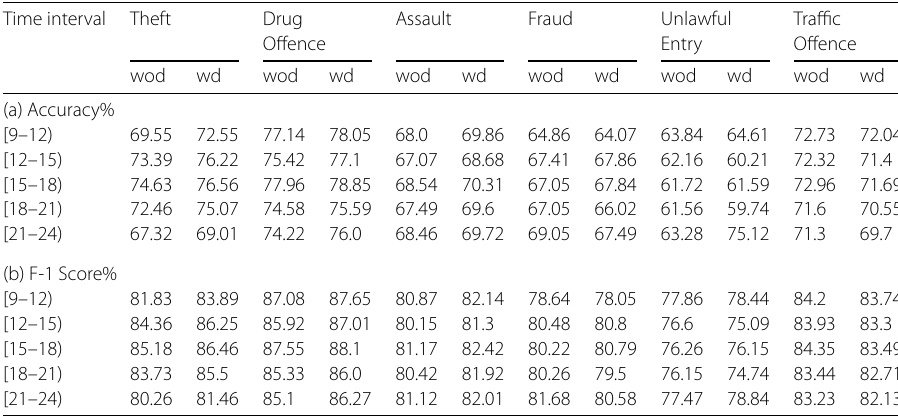
Table 7 Metrices comparison with and without dynamic features for New York City (“wod” and “wd” represent without and with dynamic features respectively) Time interval Theft Drug Assault Fraud Offence